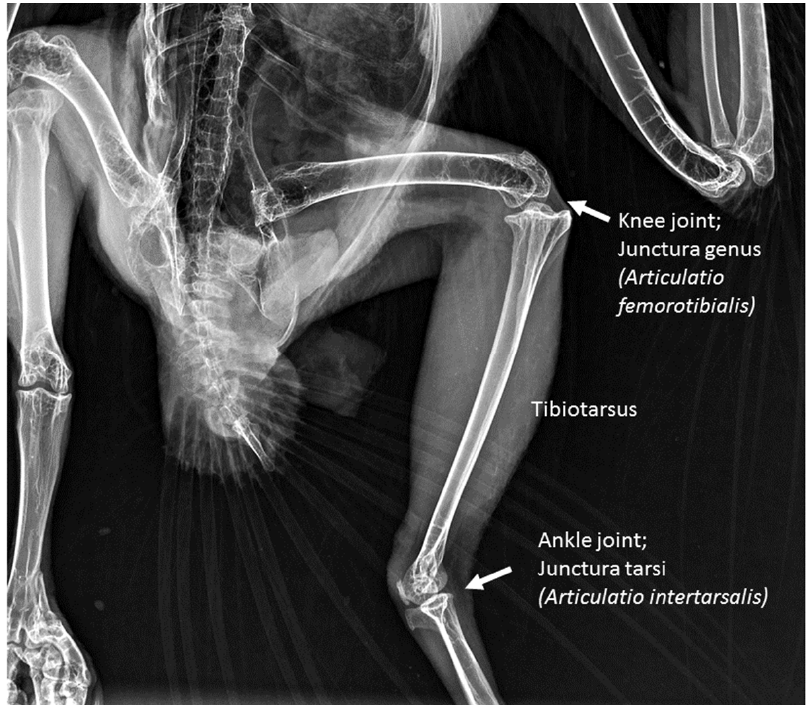
Figure 1. Tibiotarsal bones were dissected in joints pointed by arrows.